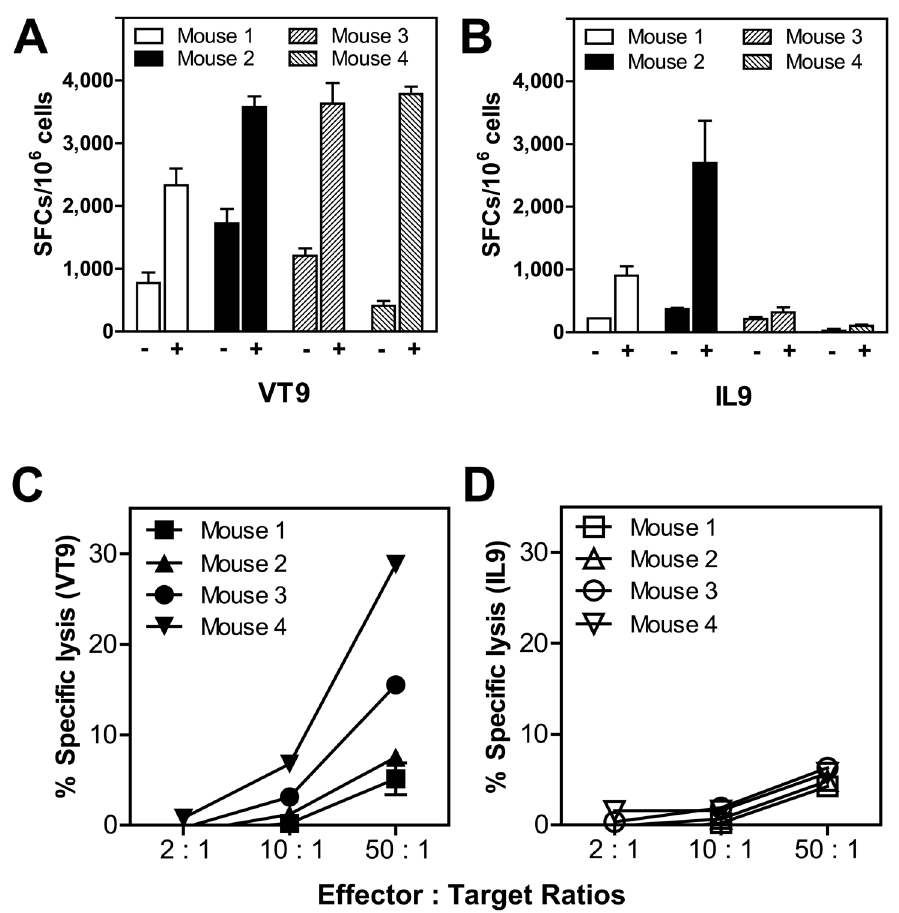
Figure 4. Immunization of HLA-A2 transgenic mice with epitopic N peptides. Two groups of four mice each were immunized subcutaneously and boosted ten days later with 100 m g of VT9 or IL9 emulsified with 100 m g PADRE in IFA. Splenocytes were collected on day 15 and re-stimulated in vitro with cognate peptide-pulsed irradiated syngeneic LPS blast cells for seven days. Peptide-specific responses were assessed by IFN c ELISPOT and chromium release cytotoxicity assays. Panels A and B show the number of SFCs per million splenocytes from mice immunized with VT9 or IL9, respectively with and without the cognate peptide. Panels C and D show the percent specific lysis of cognate peptide-pulsed T2 target cells mediated by cultured splenocytes.